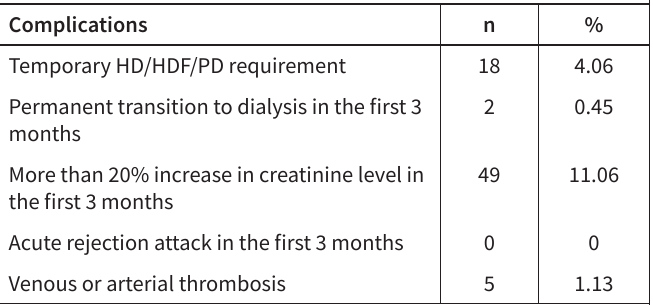
Table 4. Frequencies of COVID-19-Related Complications in Kidney Transplant